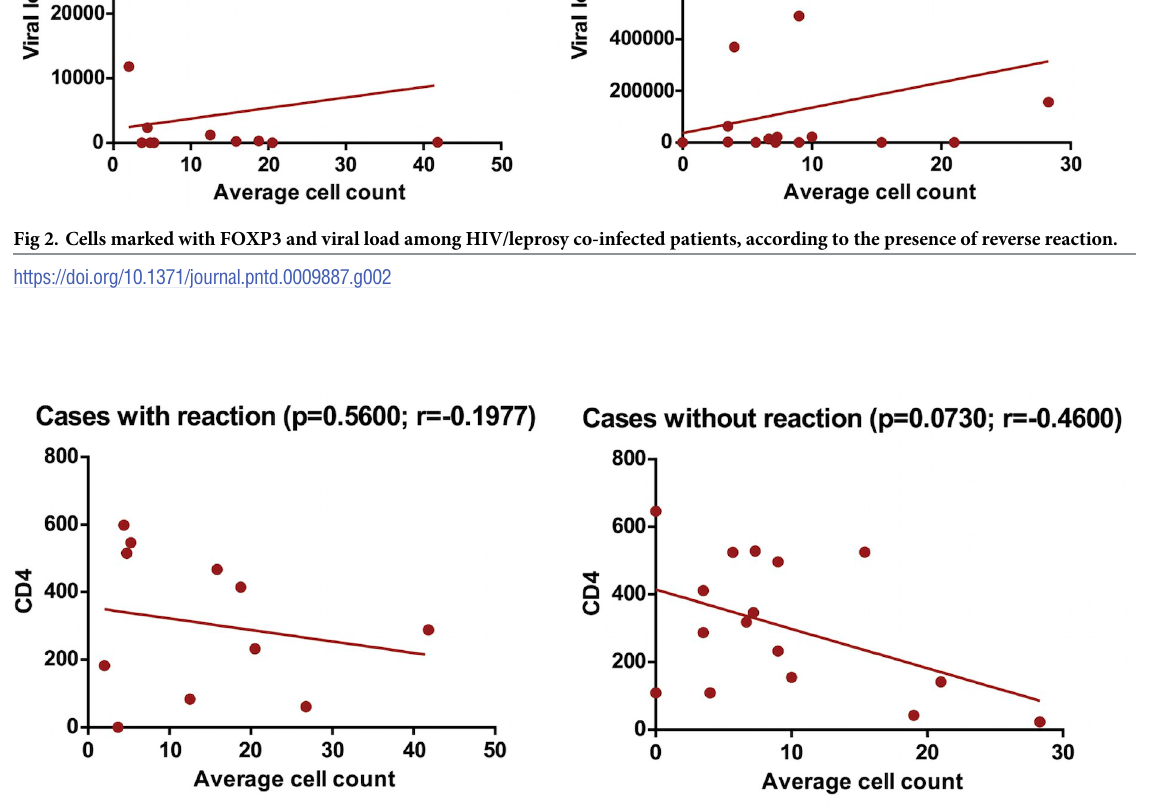
Fig 3. Cells marked with FOXP3 and CD4 T cells among patients with HIV/leprosy coinfection, according to the presence of reverse reaction.